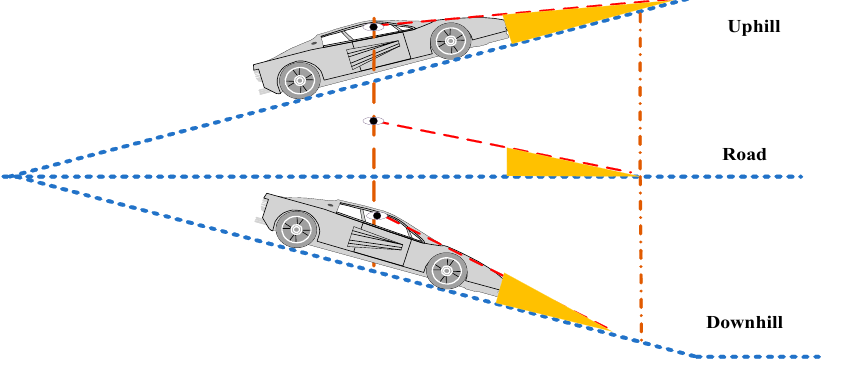
Figure 2. The front blind area of the car changes when the car is going uphill, is on flat road, and going